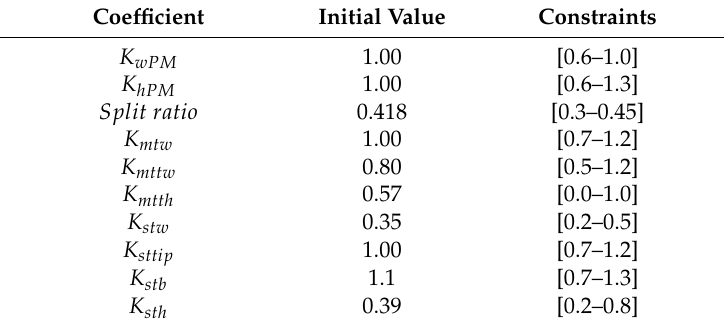
Table 6. Optimization coefficients and constraints.